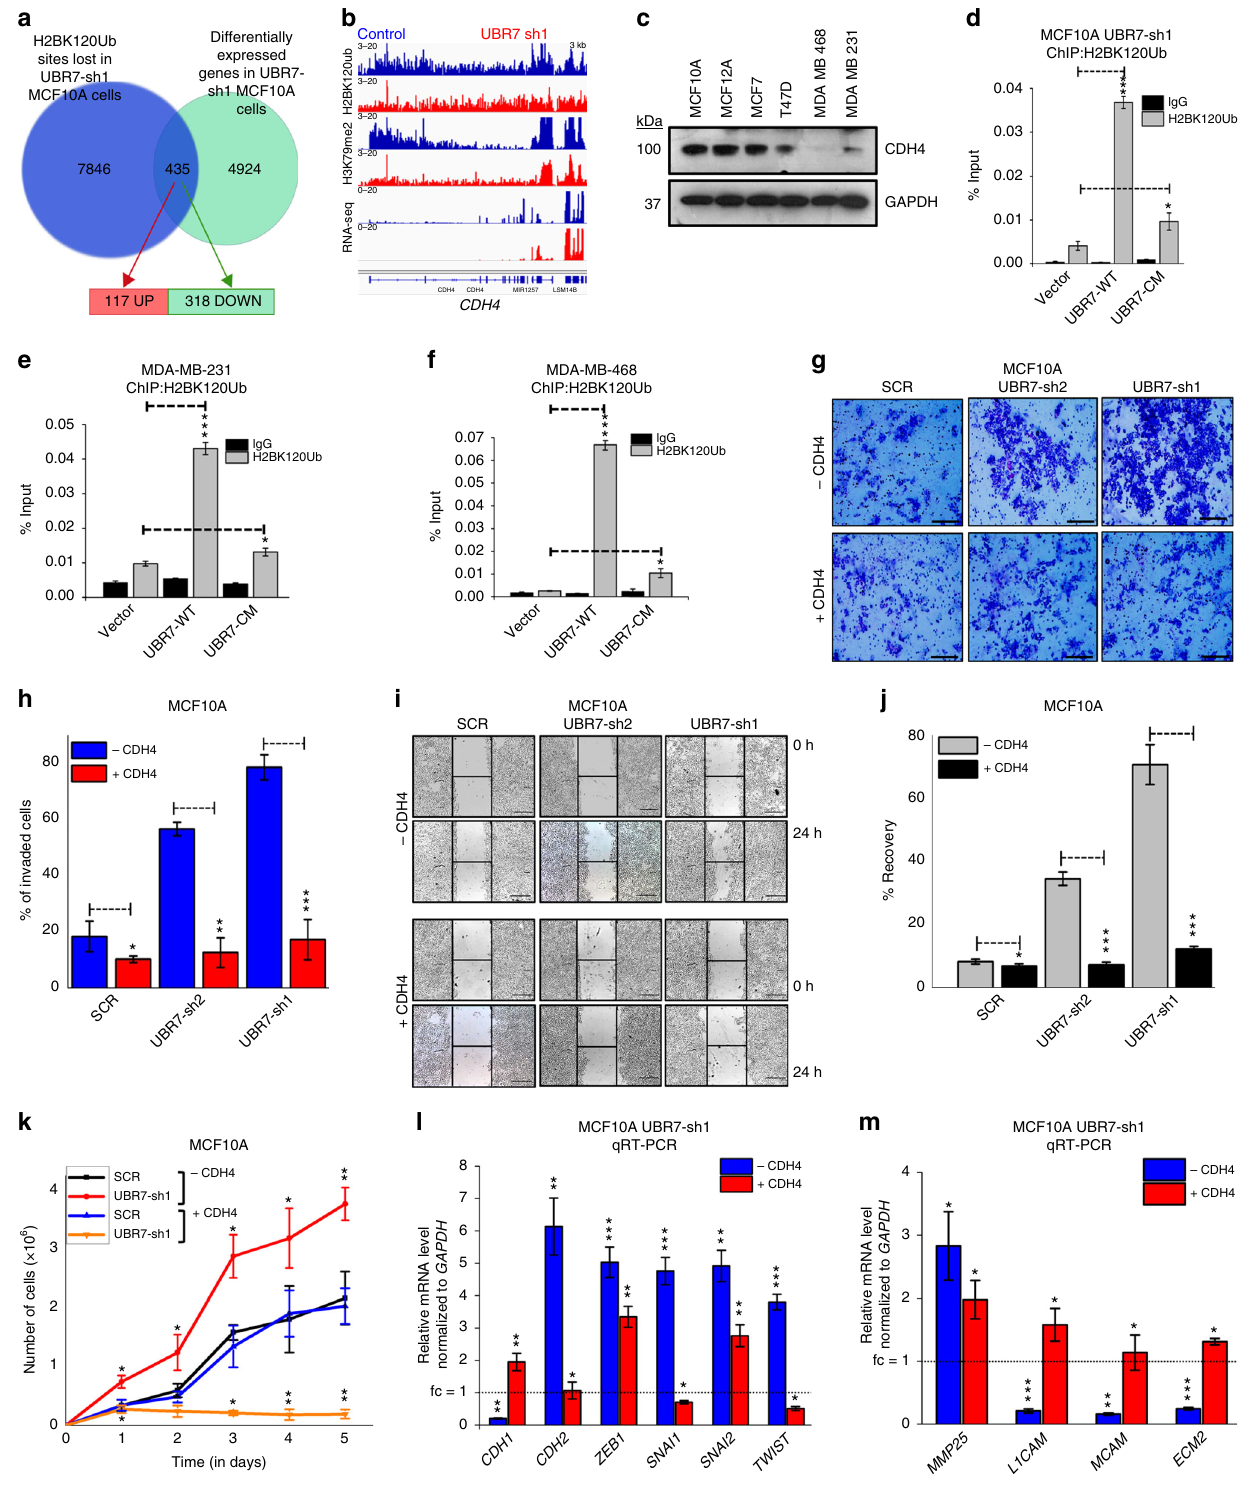
Nucleosome isolation . Nucleosomes were prepared freshly from HeLa cells as described previously 45 . Brie fl y, the nuclear pellet from HeLa cells was digested with MNase (0.2 Units/µl; Sigma) and extracted with TE buffer for 1 h. The mono- nucleosome was separated via sucrose gradient (5 – 40%) ultracentrifugation using Sorvall WXUltra100 (Thermo Fischer Scienti fi c) with AH650 rotor for 16 h at 207,203 × g . For further analysis, these fractions were pooled and concentrated. In vitro ubiquitination assay . In vitro ubiquitination reactions were set up with puri fi ed UBR7-PHD, UBR7-WT, or UBR7-CM (H163S/H166S) as E3 enzymes